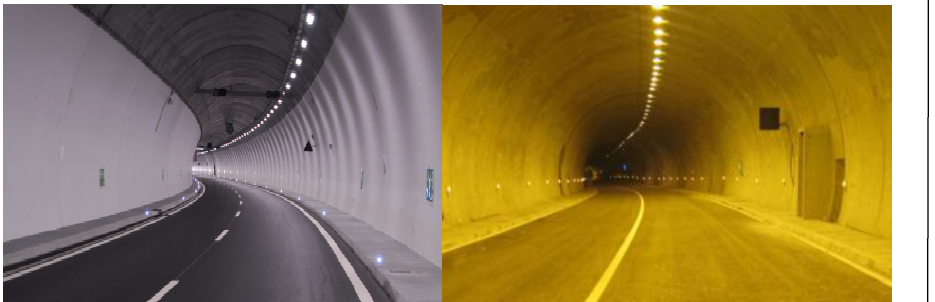
Figure 1 – Tunnels for traffic in Baltimore (left) and Switzerland (right), figure sources: https://en.m.wikipedia.org/wiki/Cut_and_cover#Cut-and-cover (left), https://www.ethz.ch/en/news-and-events/eth-news/news/2013/11/a-land-of-tunnels.html (right) Рис . 1 – Автодорожные тоннели в Балтиморе ( слева ) и Швейцарии ( справа ),